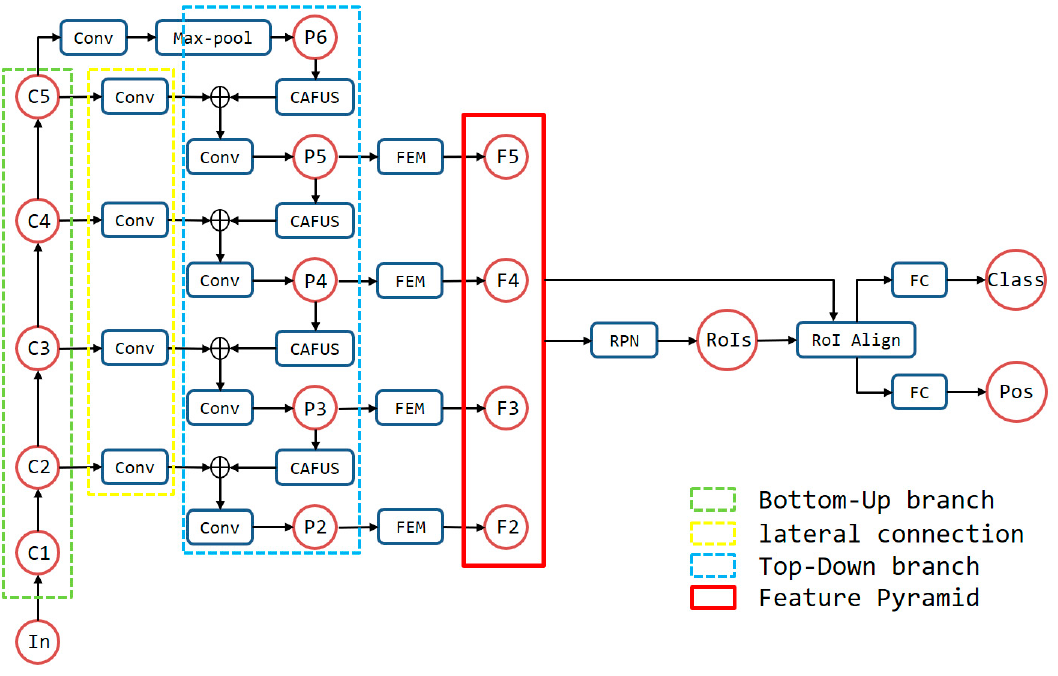
Figure 2. The structure of the Multi-stage FEPN. The green dashed box represents the bottom-to-top branch, the blue dashed box represents the up-to-down branch, and the yellow dashed box represents lateral connection branch. Finally, the feature maps in red box form the feature maps group {F2, F3, F4, F5}.